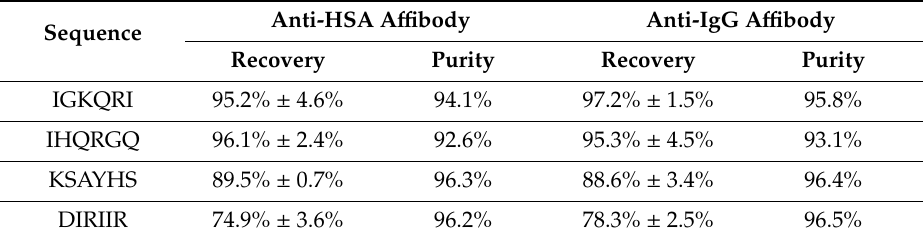
Figure 1. SDS-PAGE (non-reducing conditions, Coomassie stained) of unbound (UB) and elution (EL) fractions obtained by purifying anti-HSA and anti-hIgG affibodies from a clarified Escherichia coli cell lysate using ( A ) IGKQRI–GSG–Toyopearl, ( B ) IHQRGQ–GSG–Toyopearl, ( C ) KSAYHS–GSG–Toyopearl, and ( D ) DIRIIR–GSG–Toyopearl resins. Labels: MW, molecular weight marker; L, load; UB, unbound; EL, elution at pH 3.8; Aff, affibody standard (pure anti-HSA affibody). Table 3. Recovery and purity of anti-HSA and anti-IgG a ffi bodies purified from clarified E. coli cell lysate using the adsorbent IGKQRI–GSG–Toyopearl, IHQRGQ–GSG–Toyopearl, KSAYHS–GSG–Toyopearl, and DIRIIR–GSG–Toyopearl resins. The values of yield were calculated as the ratio of the amount of fluorescently labeled a ffi body present in the eluted fractions (measured via fluorescence spectroscopy) vs. the loaded amount, whereas the values of purity were calculated by densitometric analysis of the elution (EL) lanes in the gel reported in Figure 1 using Image Lab software (Bio